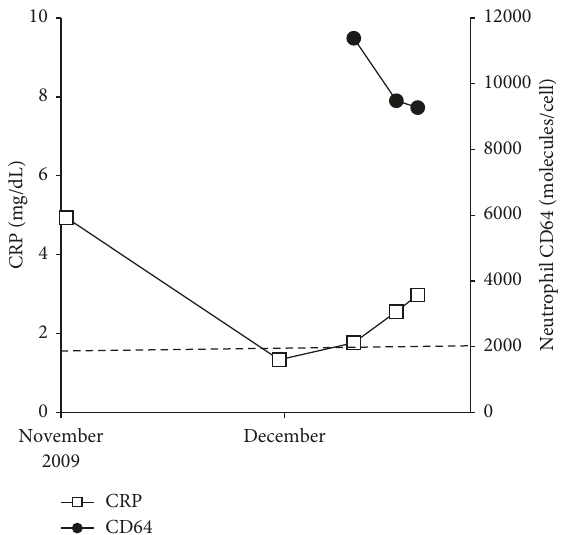
Figure 5: High levels of neutrophil CD64 were maintained since admission to the hospital (case 3).